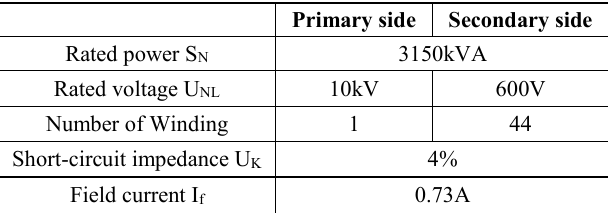
Table 1. The basic parameters of multi-winding transformer.